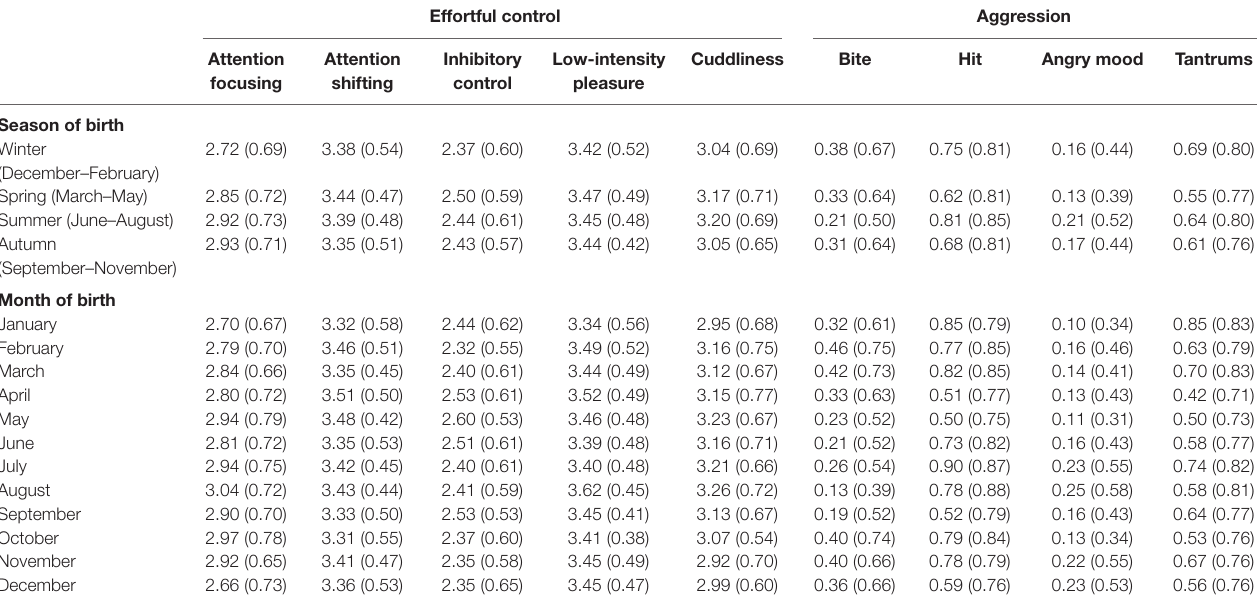
TaBle 2 | Means and sDs for subscales of effortful control and aggression by season and month of birth ( N = 885). effortful control aggression attention focusing